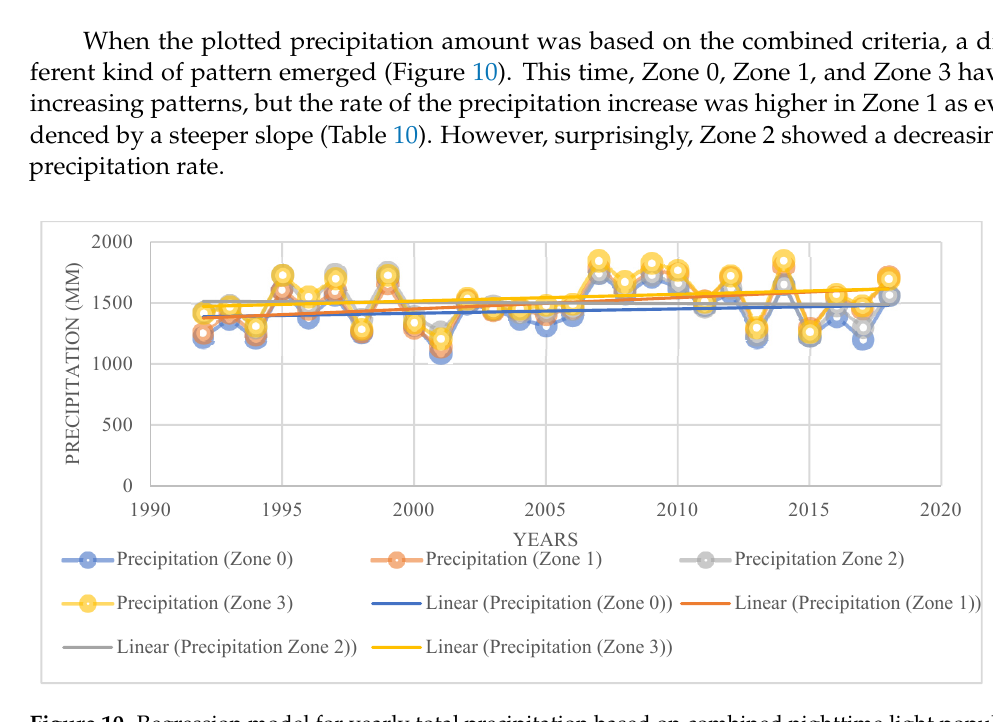
Table 10. Linear Regression Results When Combined Criteria are Considered.